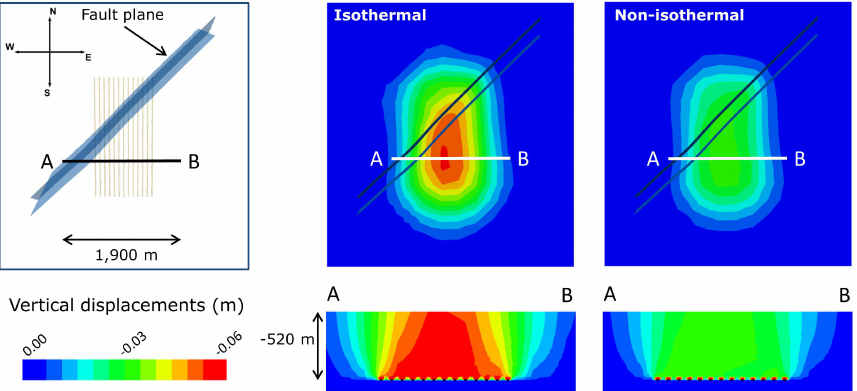
Figure 5. Plane views of the vertical displacement distribution at the ground surface ( top ) and cross-sections ( bottom ) for the isothermal ( middle ) and non-isothermal ( right ) scenarios after 2000 days of simulation (end of operation). The location of the UCG channels and the fault plane with regard to the plotted cross-section is illustrated in the upper left sub-figure.